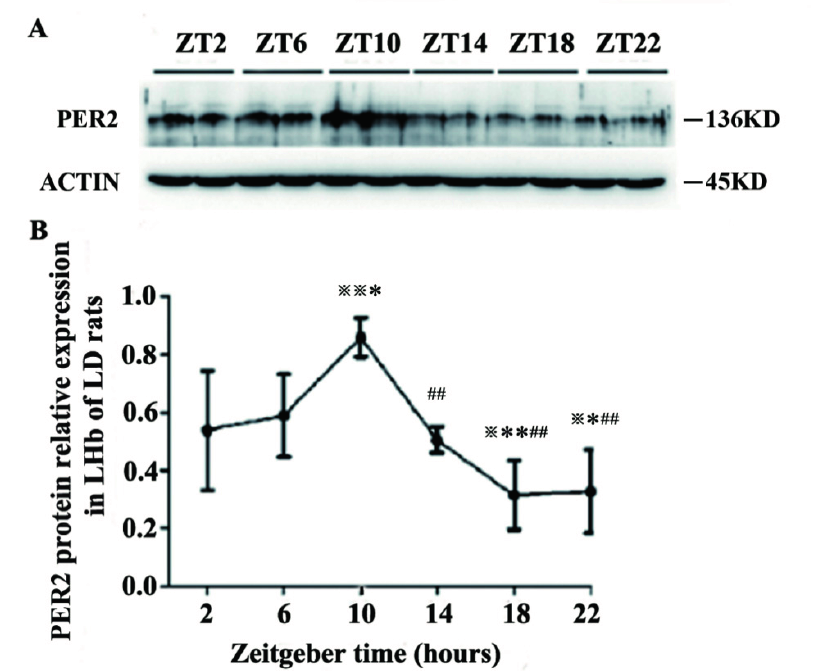
Figure 2. Rhythmic expression of PER2 protein in the LHb of LD rats. ( A ) Western blotting of PER2 and β -actin bands in the LHb at six ZT time points; and ( B ) Relative density of PER2 bands was normalized against β -actin bands at six ZT time points. Data are presented as mean ± SD ( n = 6). ※ p < 0.05 and ※※ p < 0.01 compared with ZT2 time point; * p < 0.05 and ** p < 0.01 compared with ZT6 time point; ## p < 0.01 compared with ZT10 time